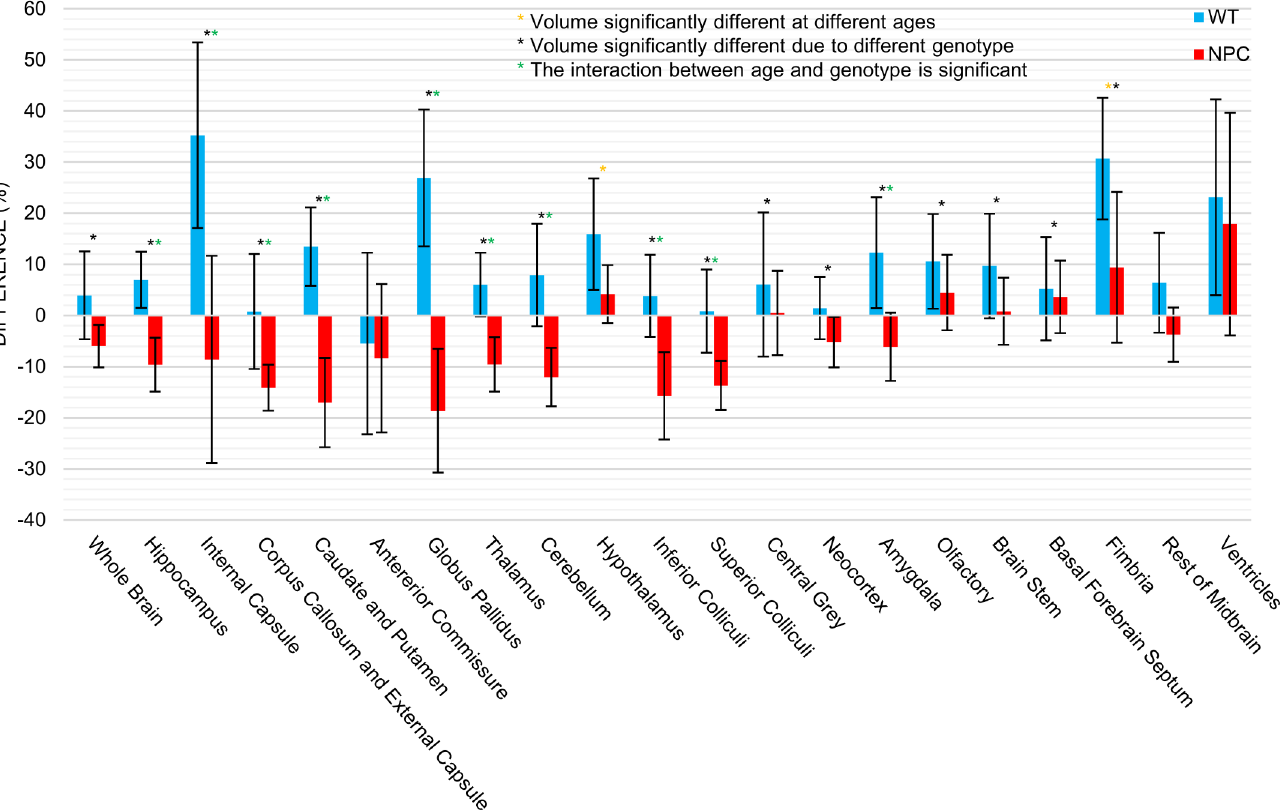
Fig 4. Change in the volume of mouse brain regions with age. Percent change in wholebrain and brain regionvolumes between3 and 9 months of age for WT (blue) and Npc1 -/- (red) mice. Errors bars indicate the standarddeviationof the percent change.Significanteffects of genotype( * ) and age ( * ) and significantinteractionbetweenage and genotype( * ) were determined from a two-way ANOVA and p < 0.05after Holm-Bonferroni correction.